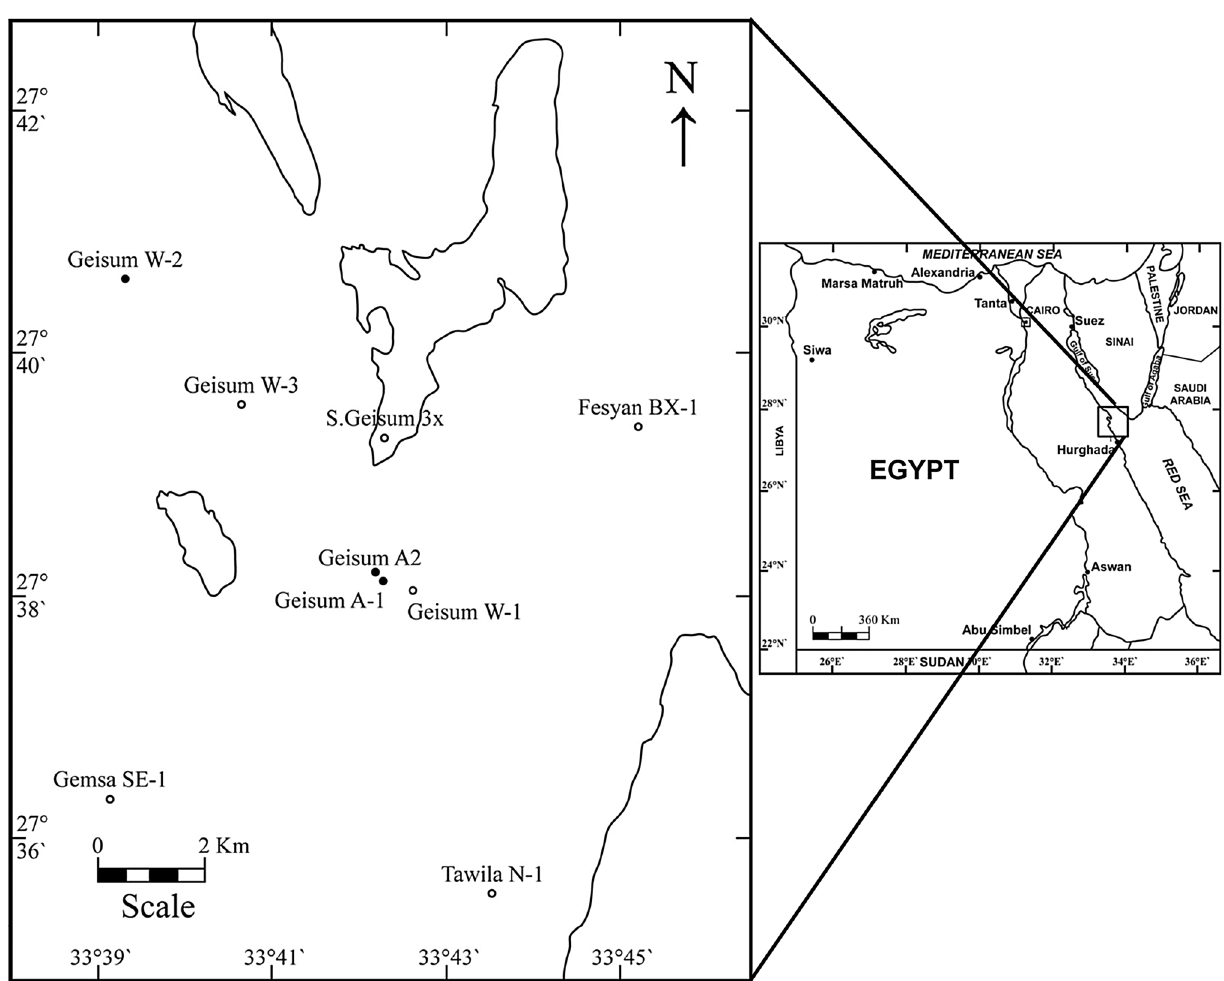
Fig. 1 Location map for the study area and well